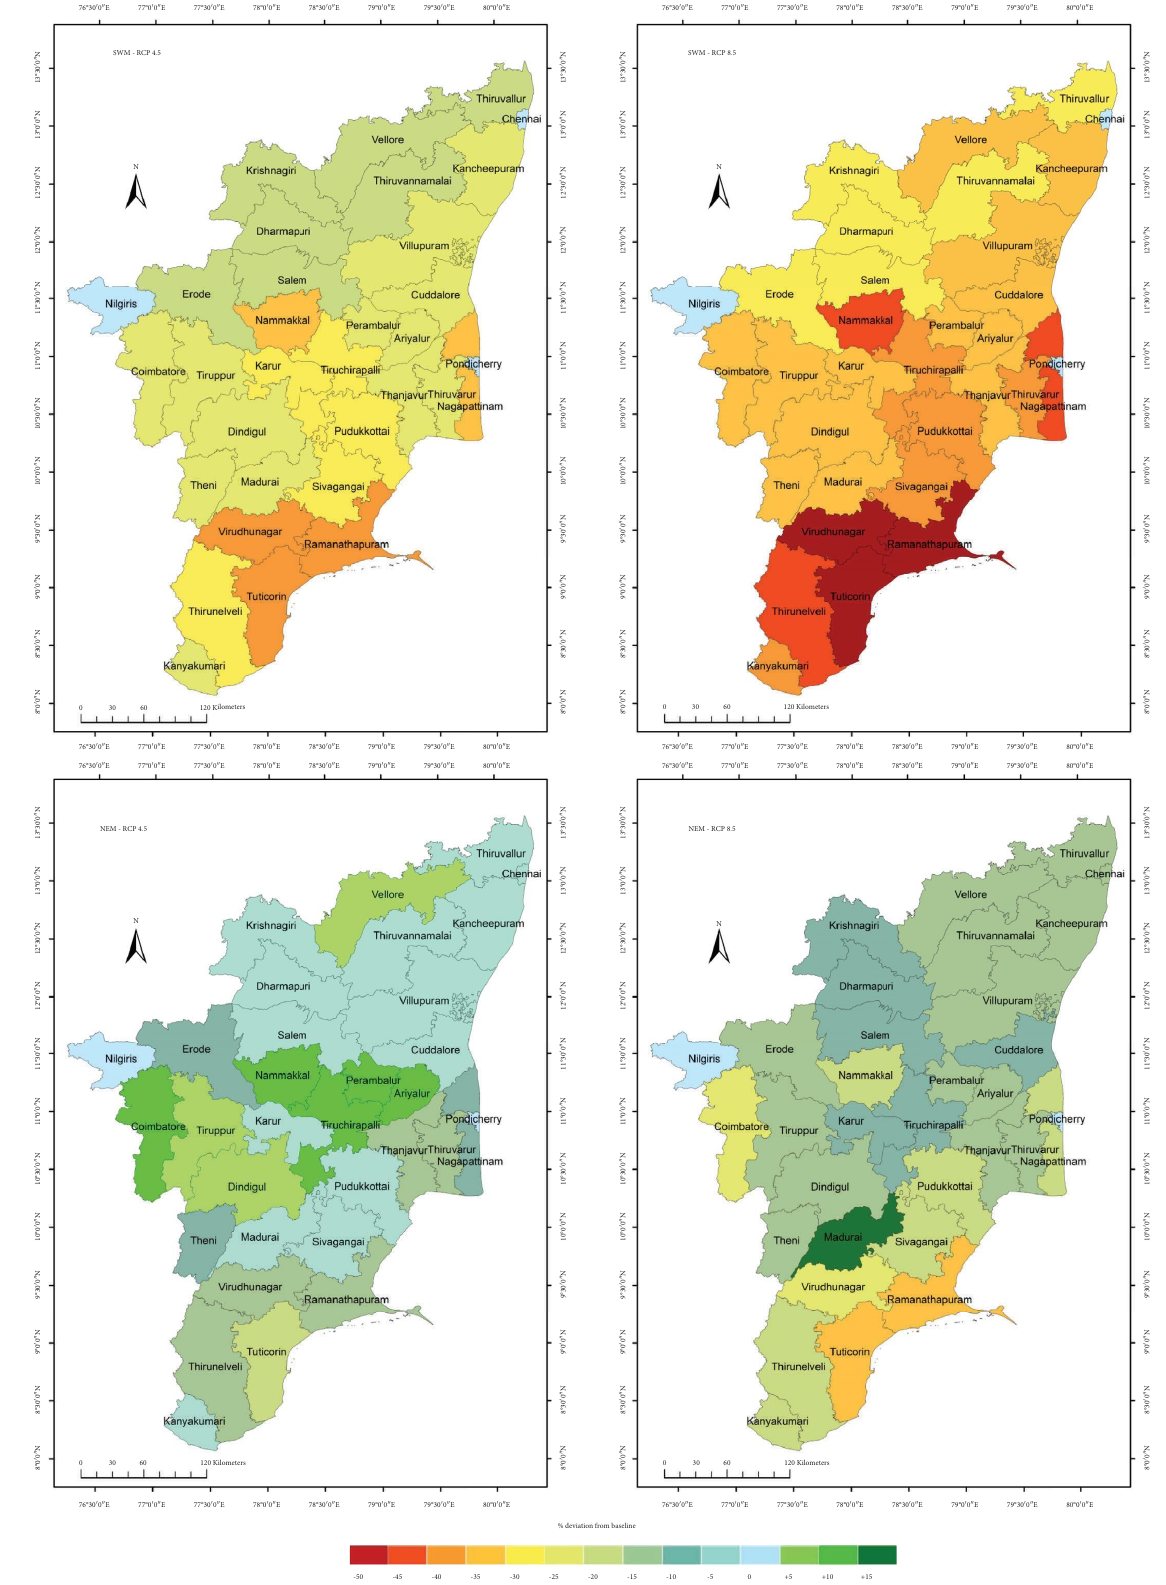
Figure 6: Spatial variability in rice productivity under multi-model ensemble climate projection during midcentury for RCP 4.5 and RCP 8.5 during SWM and NEM